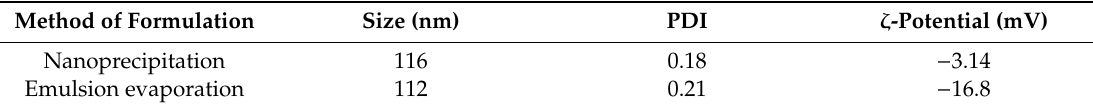
Table 1. Size, polydispersity index (PDI) and ζ -Potential of the Pd-Calix-NPs as measured by dynamic light scattering according to the method of preparation.